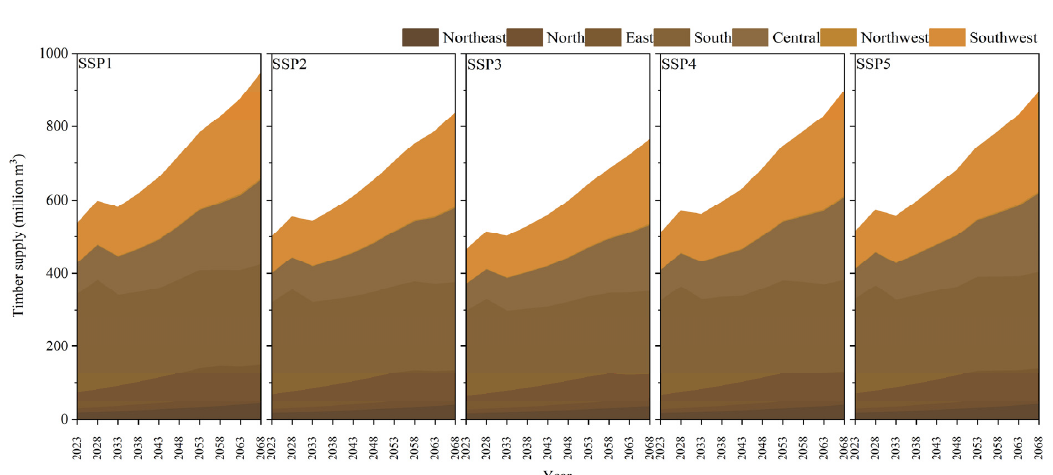
Figure A1. Regional projected timber production by SSPs in ten five-year rotation periods.